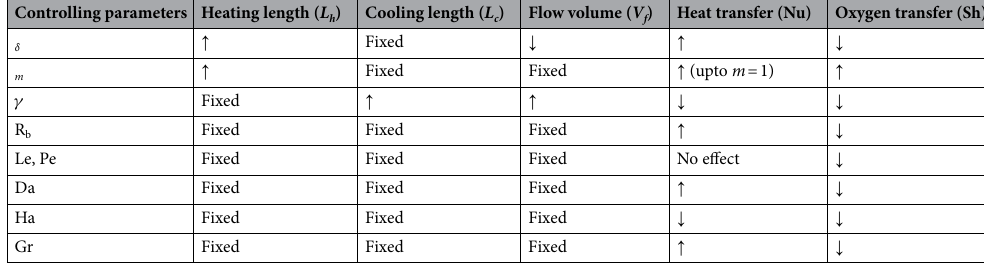
Table 9. Impact of the controlling variables on the overall triple convective behavior of the complex